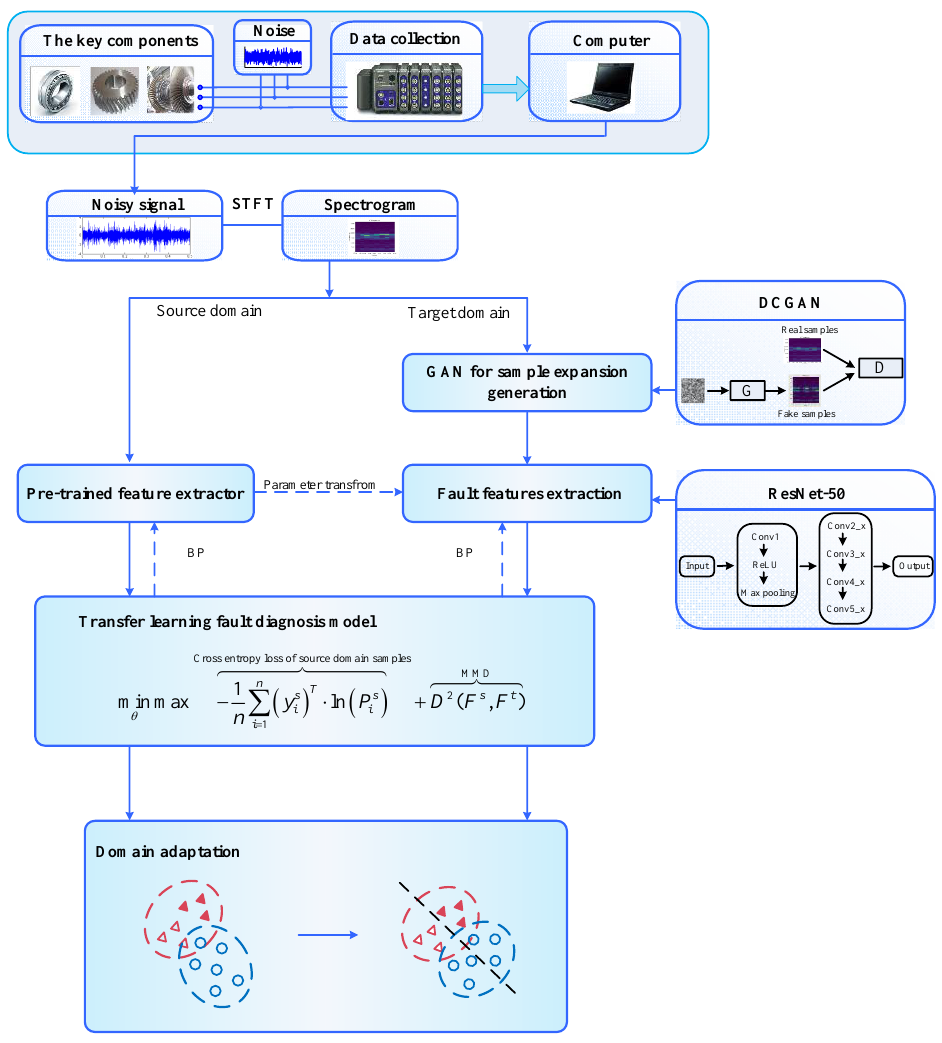
Figure 3. The entire flowchart of the proposed